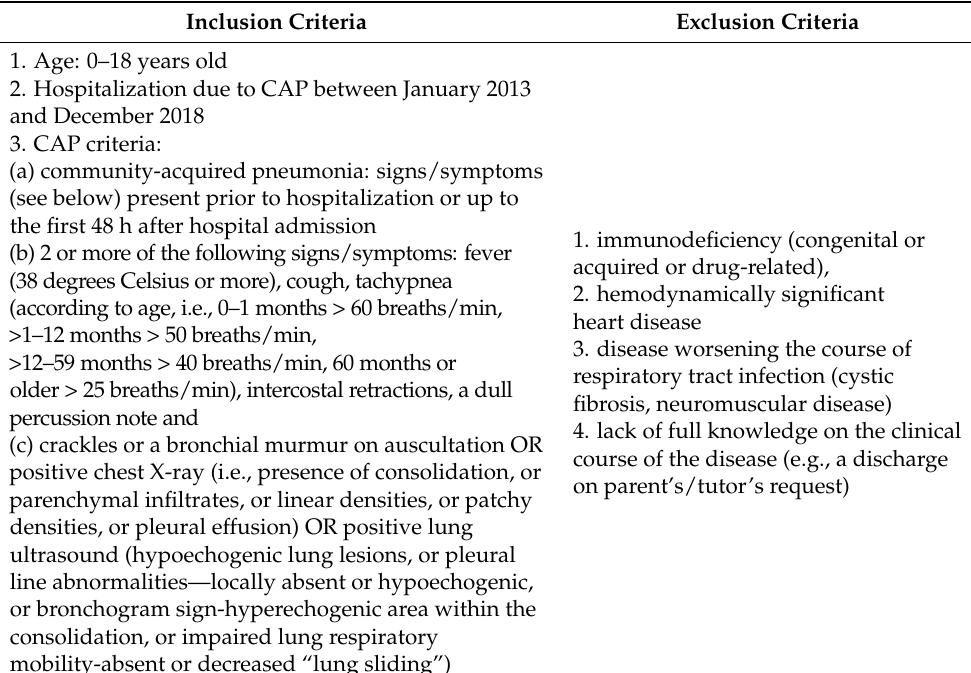
Table 1. Inclusion and exclusion